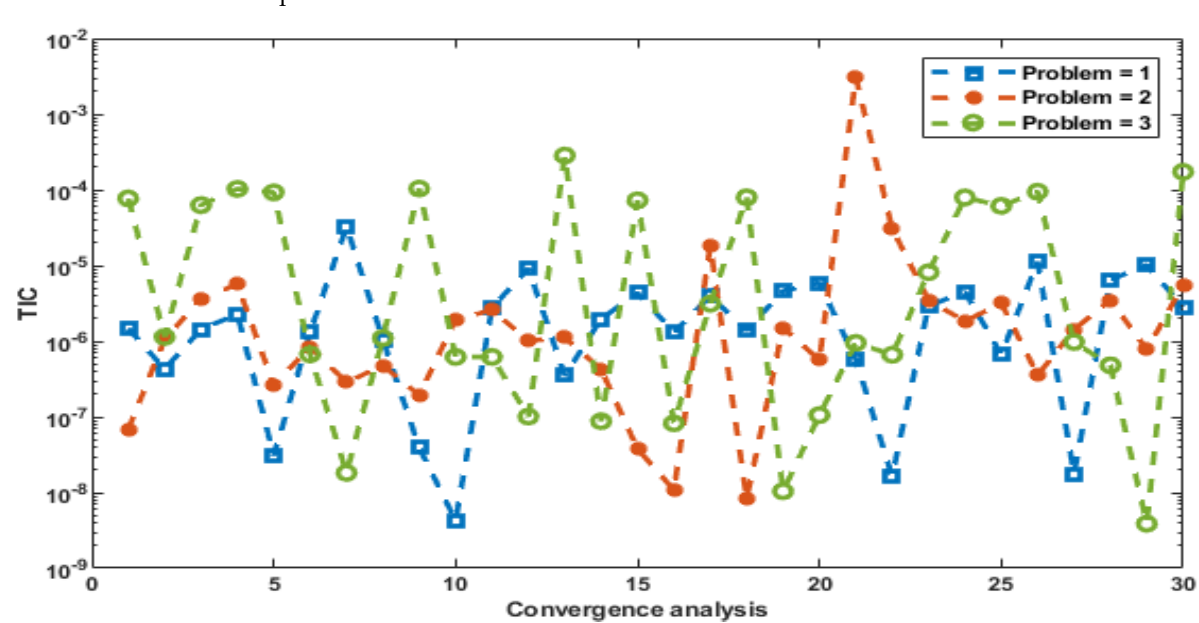
Figure 5. Convergence performance of MAD for each problem of the HO-NSDM.